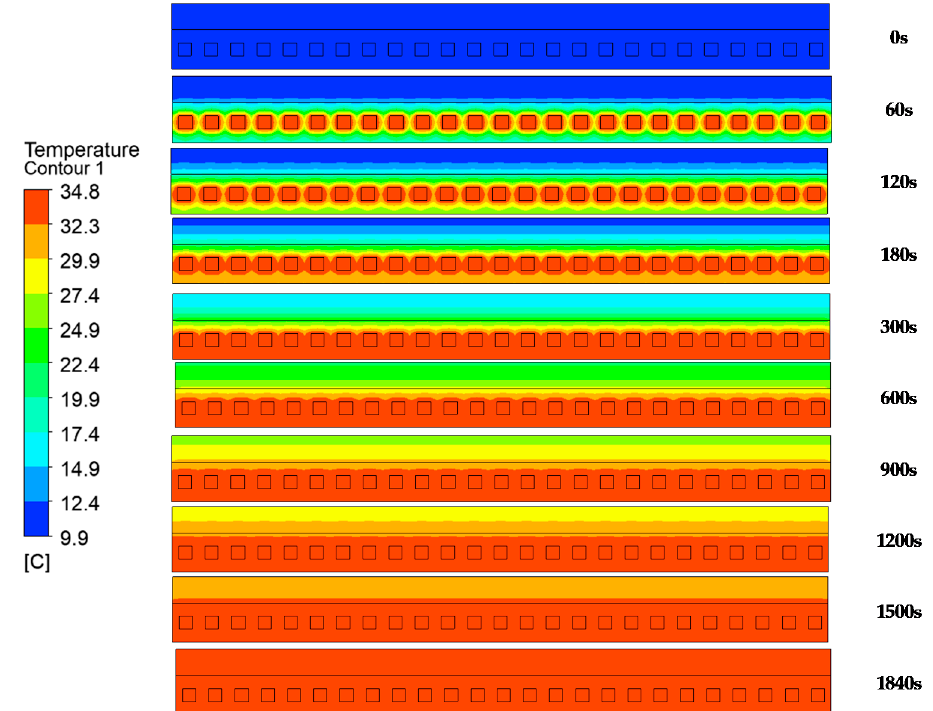
Figure 5. A section through the HPHS during the heating phase.